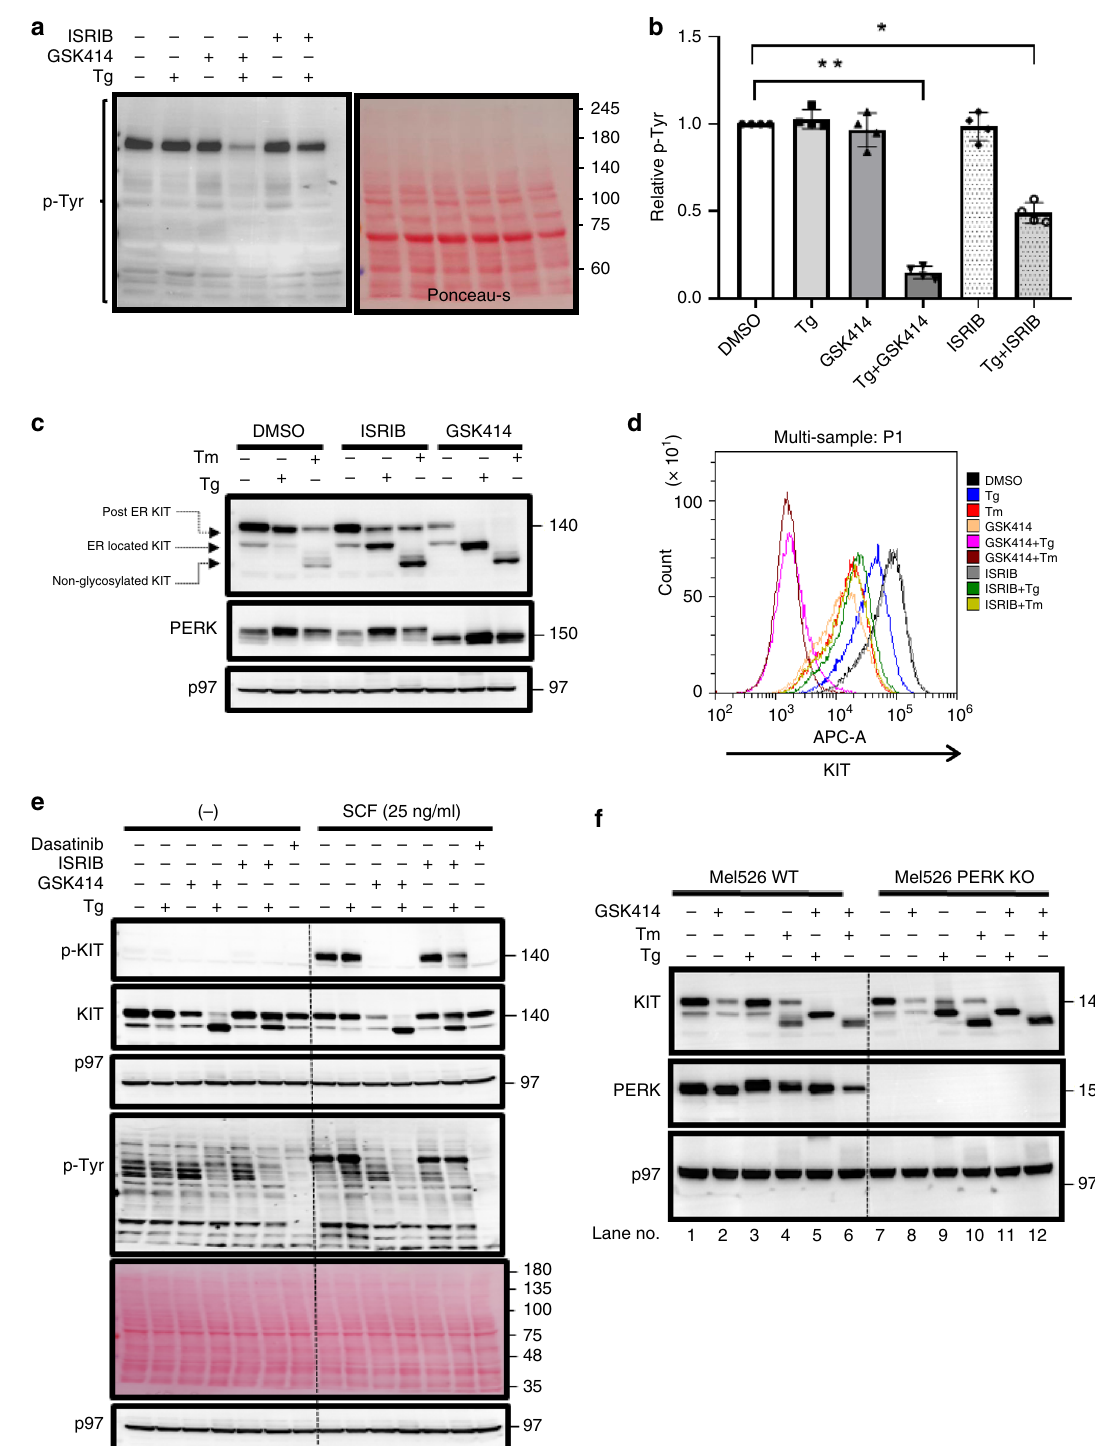
Fig. 1 Egress from the ER of KIT requires PERK/ISR signaling under ER stress. a Immunoblotting against p-Tyr and ponceau-s staining of Mel526 cells treated either with DMSO, GSK414 (0.5 μ M), ISRIB (0.2 μ M), and Tg (0.2 μ g/ml) alone or in combinations for 16 h. b Quanti fi cation relative to control of total P-Tyr levels for each treatment. Ponceau-s staining was used as the loading normalizer (Shown is the average ± SD of four independent experiments average, * p < 0.05, ** p < 0.01, Kruskal – Wallis one-way analysis of variance). c Immunoblotting against KIT, PERK, and αβ tubulin of Mel526 cells under Tg or Tm (added at 0.2 μ g/ml) induced ER stress in the presence of DMSO, ISRIB, or GSK414 for 16 h. Shown is a typical outcome from three independent repetitions. d Corresponding fl ow cytometry analysis of cell-surface KIT. e Mel526 WT cells were treated with Tg (0.2 μ g /ml), GSK414 (0.5 μ M), ISRIB (0.2 μ M), and dasatinib (0.5 μ M) alone or in combination. After 16 h, cells were stimulated with SCF (25 ng/ml) for 20 min followed by immunoblotting against p-KIT, KIT, p-Tyr, p97, and ponceau-s. A result of two repetitions. f Immunoblotting for KIT, PERK, and p97 of Mel526 WT or PERK KO cells treated with Tg, Tm, GSK414 alone or in combinations for 16 h. Shown is the typical outcome of the experiment ( n = 4 independent